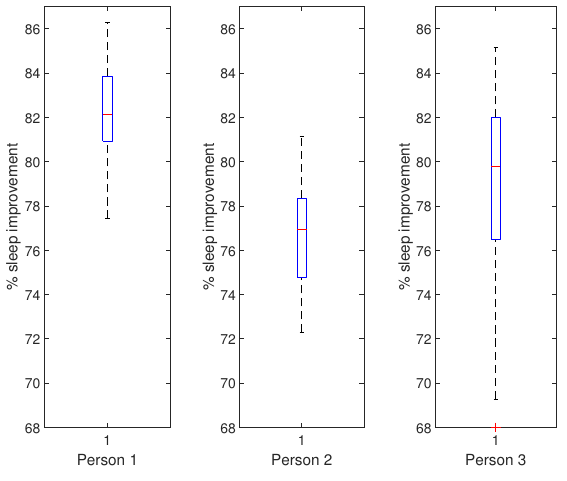
Figure 22. Box plot for three random people in the sample.